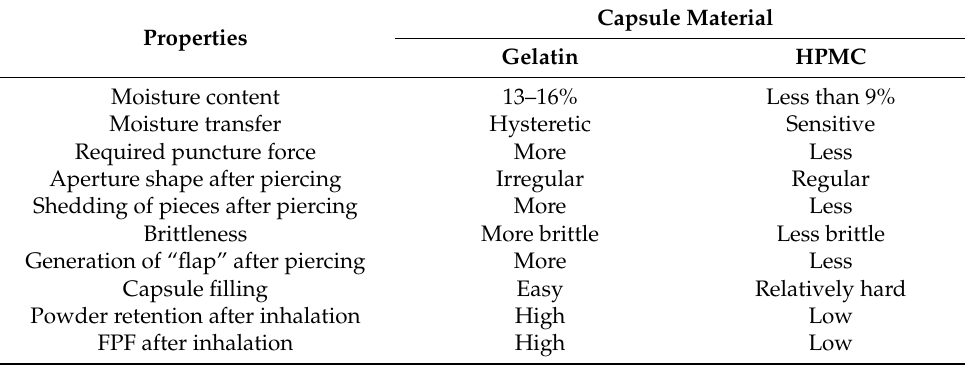
Table 2. Side-by-side comparison between the different capsule